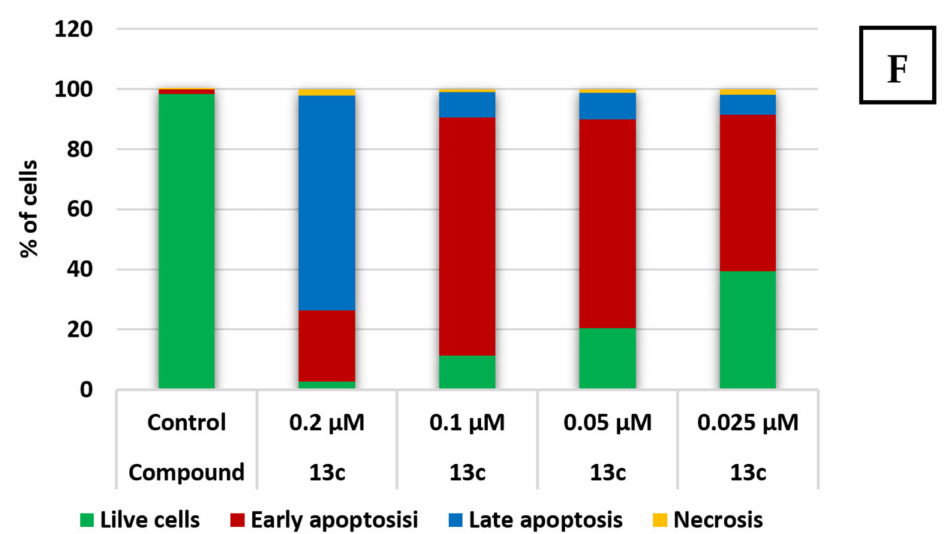
Figure 3. Analysis of the induction of apoptosis in Jurkat cells after exposure to compound 13c in various concentrations. ( A ) control sample untreated with the test compound; ( B ) compound 13c in 0.2 µ M concentration; ( C ) compound 1 3c in 0.1 µ M concentration; ( D ) compound 13c in 0.05 µ M concentration; ( E ) compound 13c in 0.025 µ M concentration; ( F ) histogram of apoptosis phases in Jurkat cells treated with compound 13c . The cells treated with compound 13c in various concentrations were stained with Annexin V/7-AAD. The incubation time of compound 13c with the cells was 24